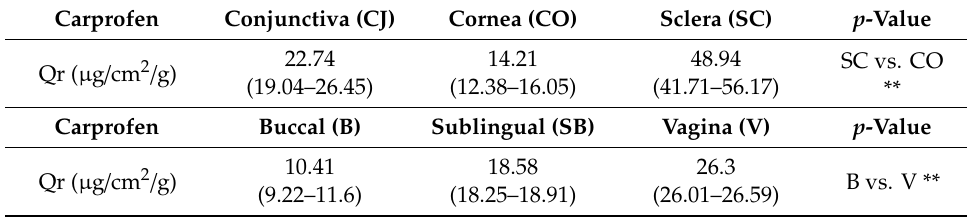
Table 5. Median, maximum and minimum values of retained amount (Qr) of carprofen at 6 h from CP-Sat through ophthalmic tissues (conjunctiva, cornea and sclera) and mucous membranes (buccal, sublingual and vaginal).